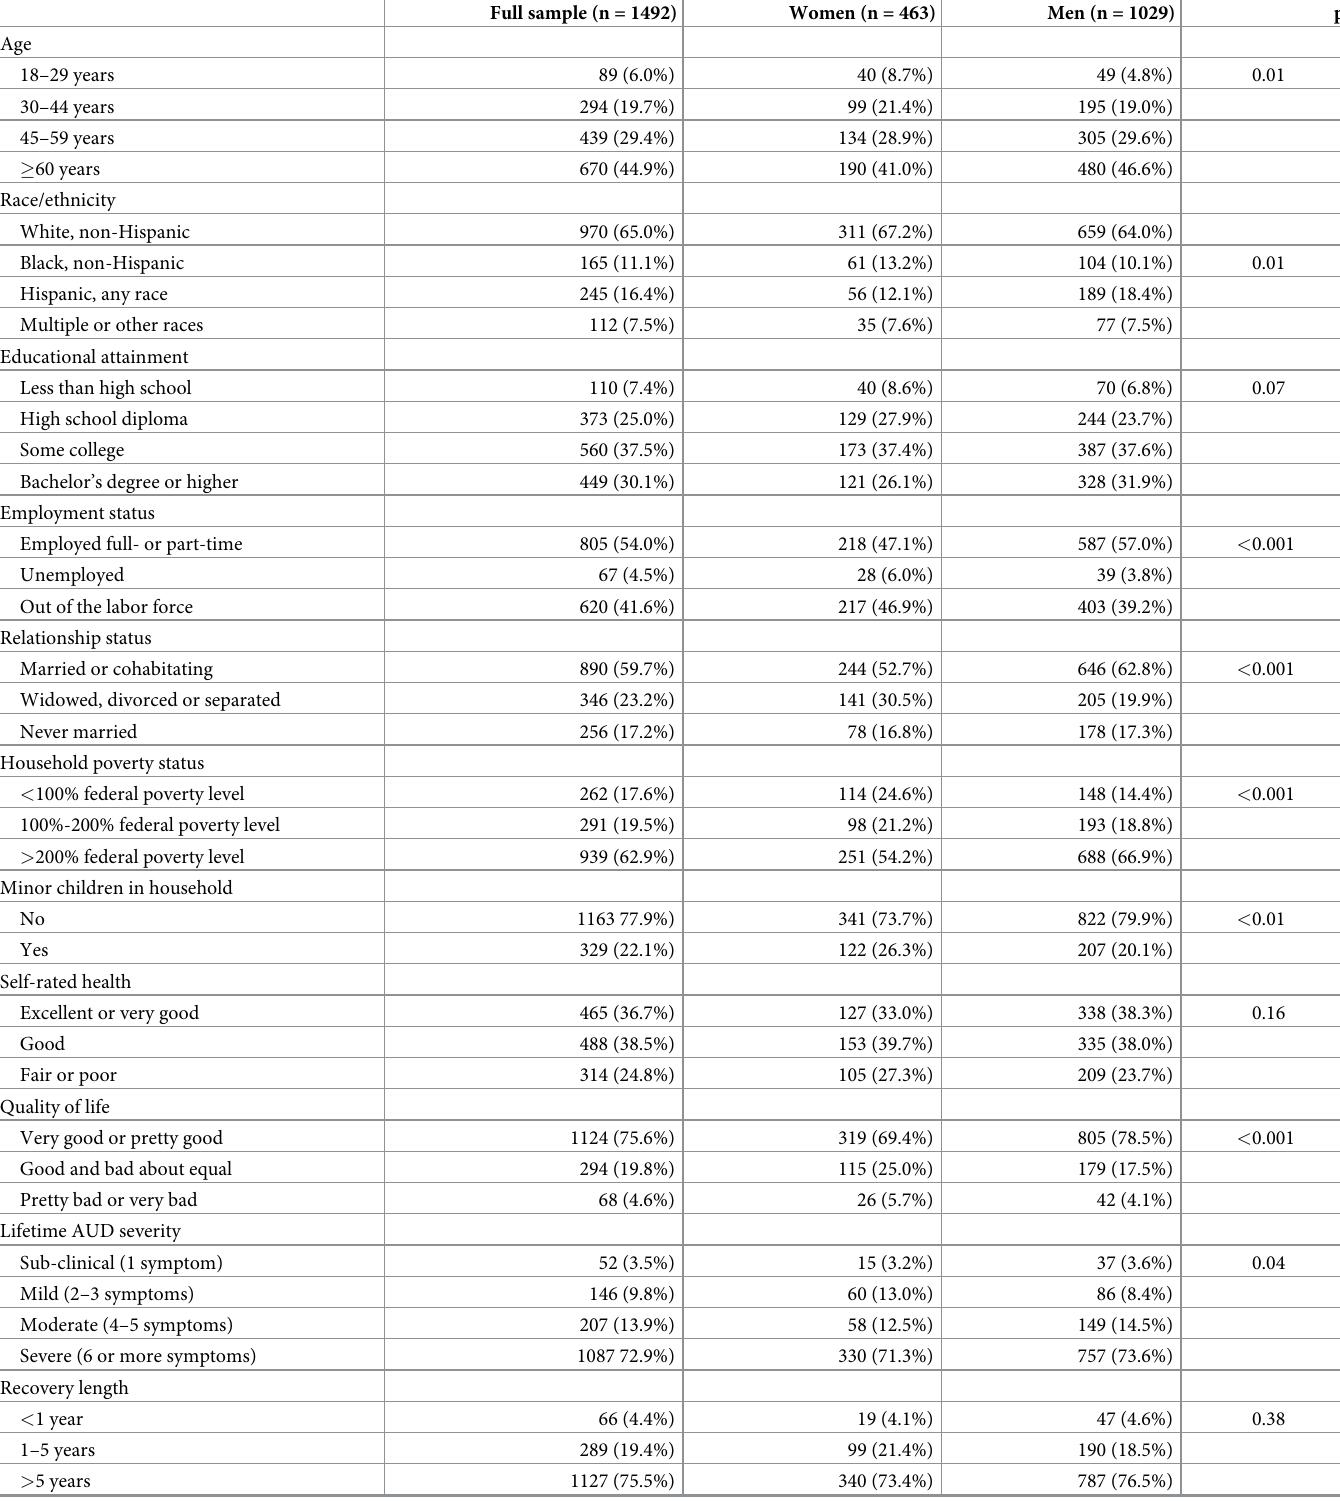
Table 1. Demographic characteristics of a US national sample of adults with a resolved alcohol